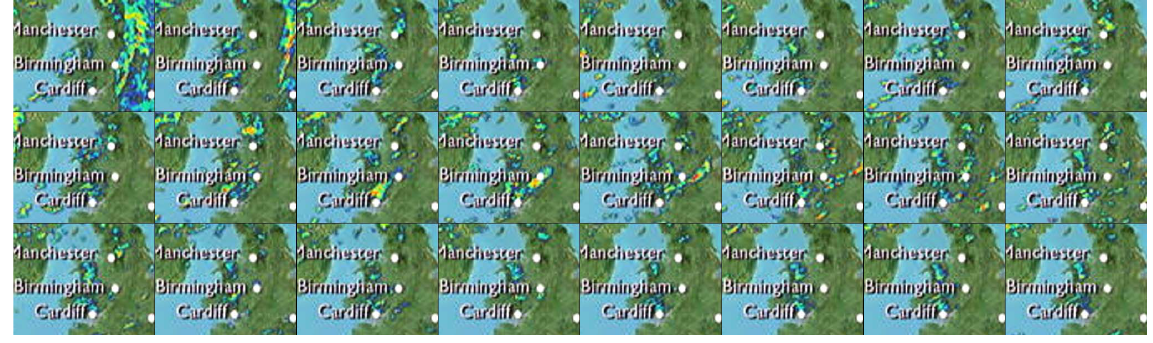
than individual cumulus clouds, not caused by satellite scan lines, and positions of “knots” are aligned perpendicular to the cloud streets, suggesting perhaps a wave pattern with phase lines perpendicular to cloud streets (Bradbury, 1990; Hindman et al.,